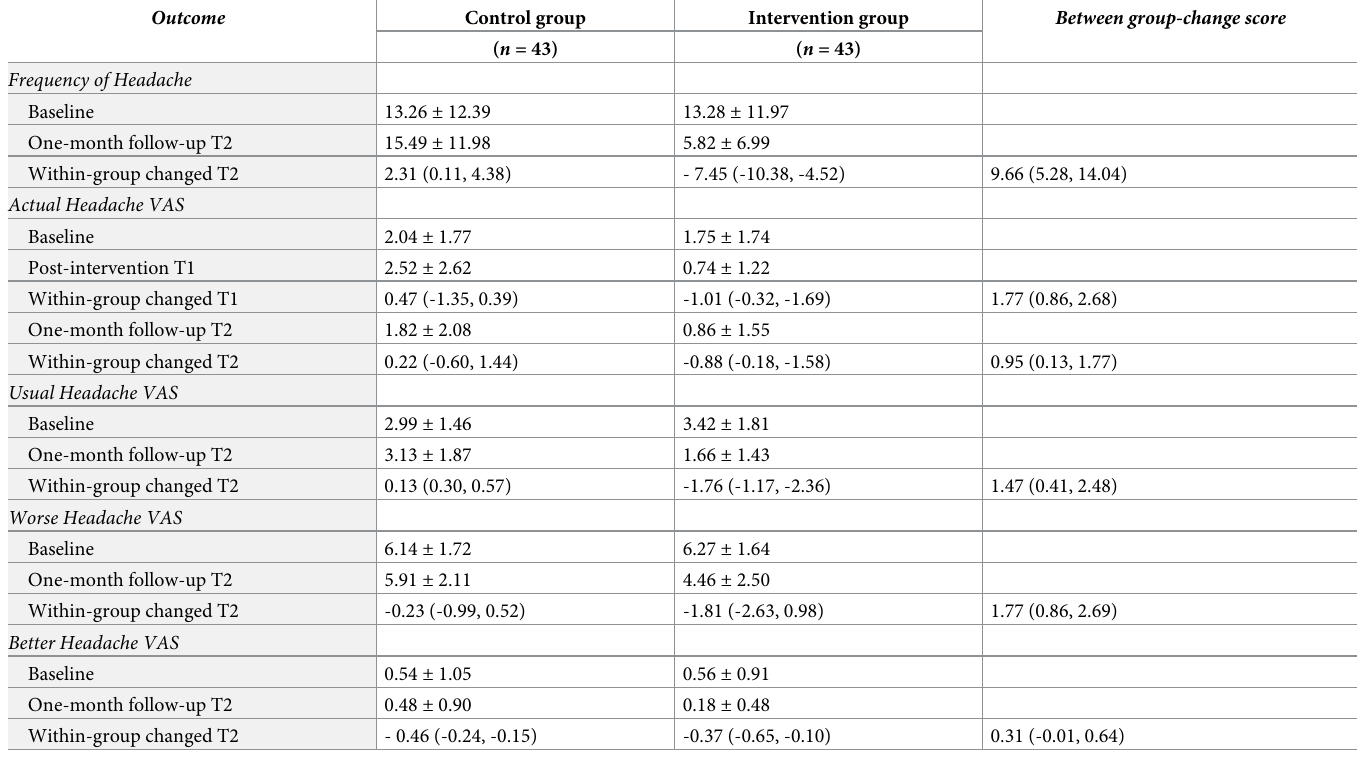
Table 2. Outcome data headache frequency and